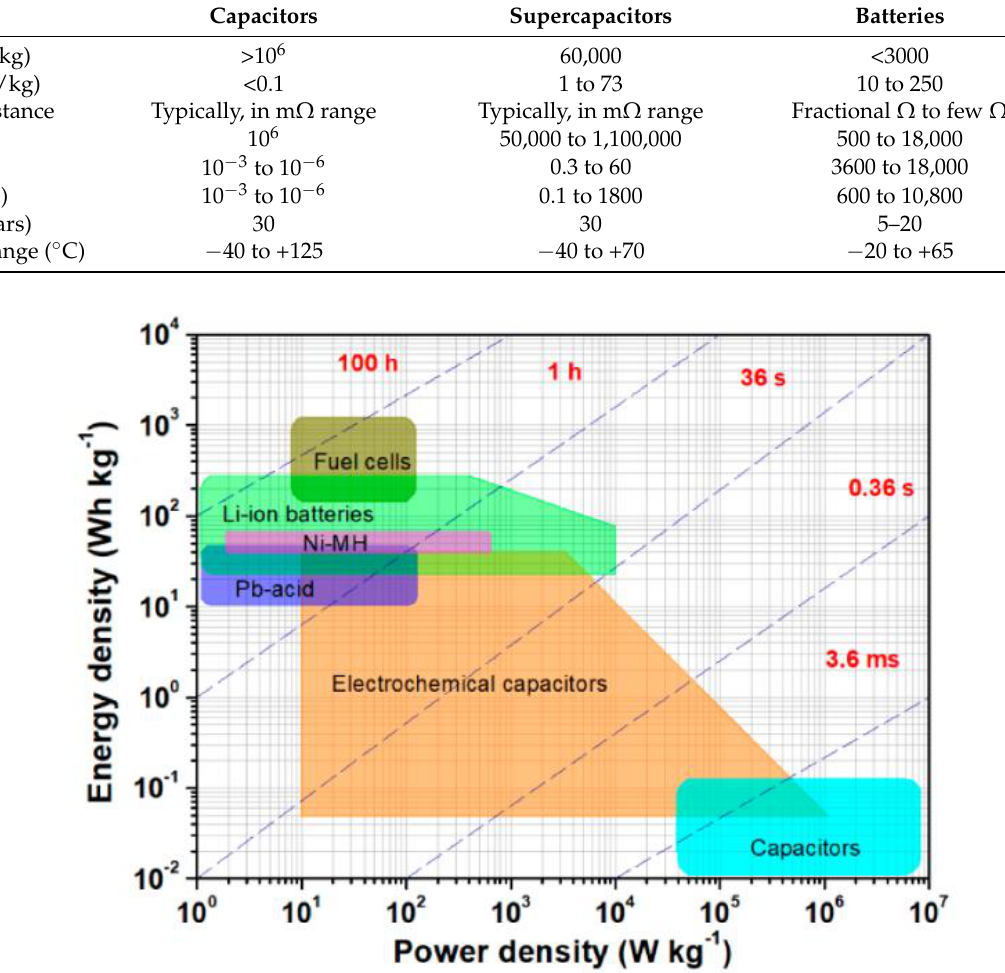
Figure 1. Ragone plot of various energy-storing technologies [4] .